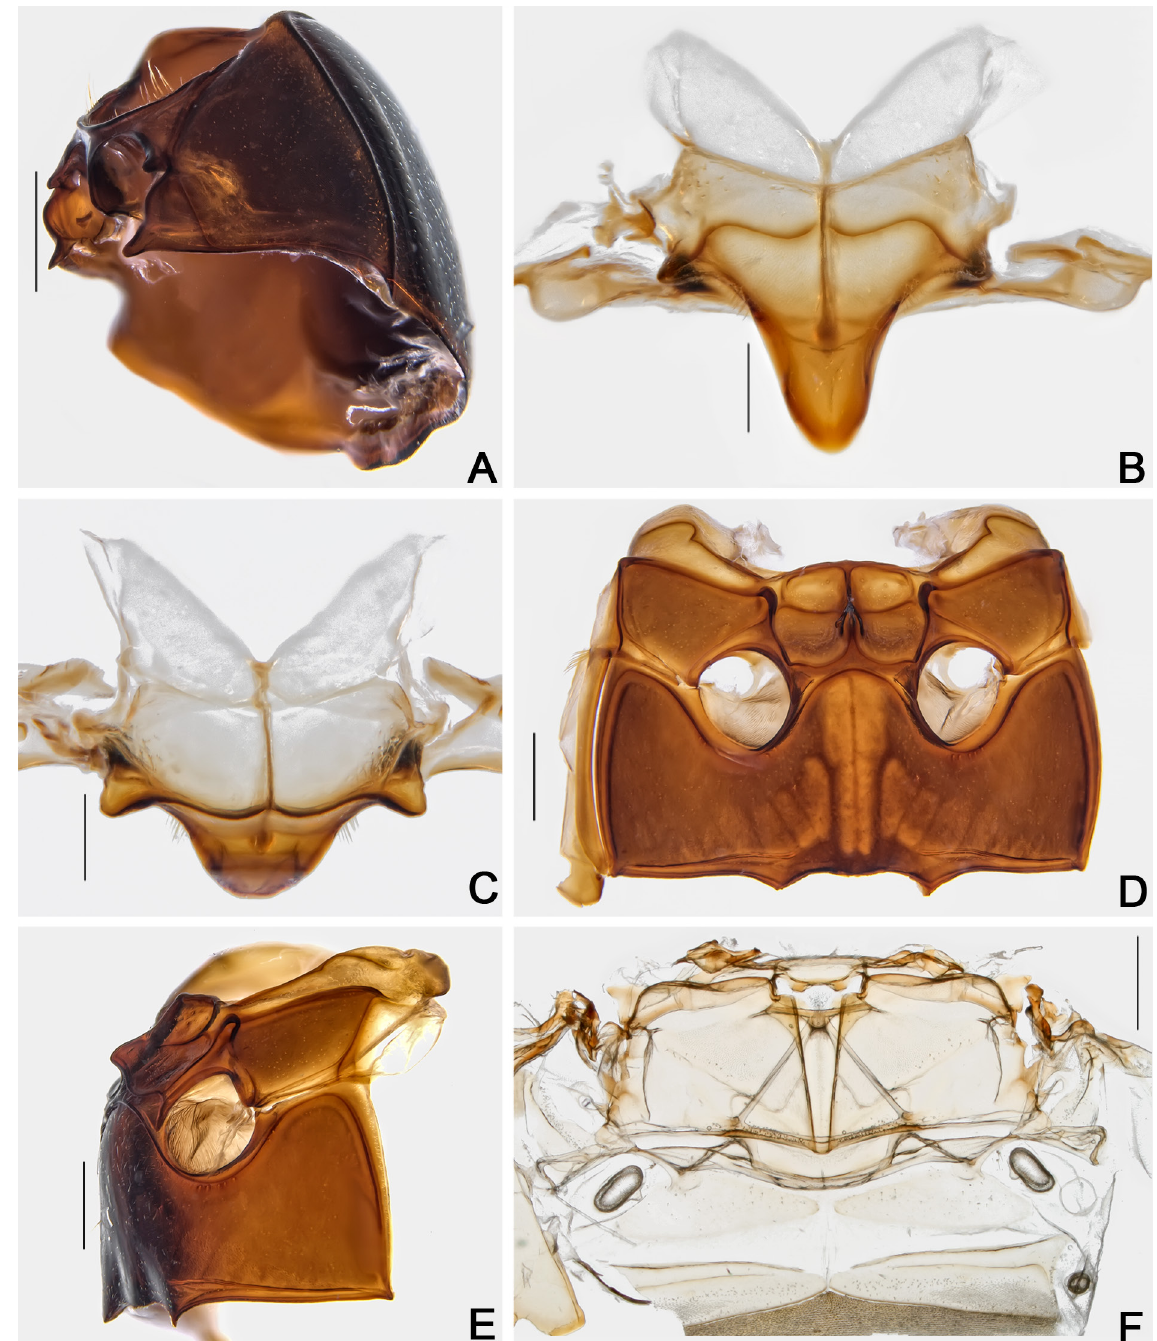
Fig. 59. Cyparium oberthueri Pic, 1956, ♂♂ (CELC). A . Prothorax, lateral view. B–C . Scutellar plate. B . Dorsal view. C . Apically slanted view. D–E . Meso- and metathorax. D . Ventral view. E . Lateral view. F . Metanotum. Specimens collected at Mata da Biologia, Viçosa (MG, Brazil) (CELC). Scale bars: A, D–F = 0.5 mm; B–C = 0.2